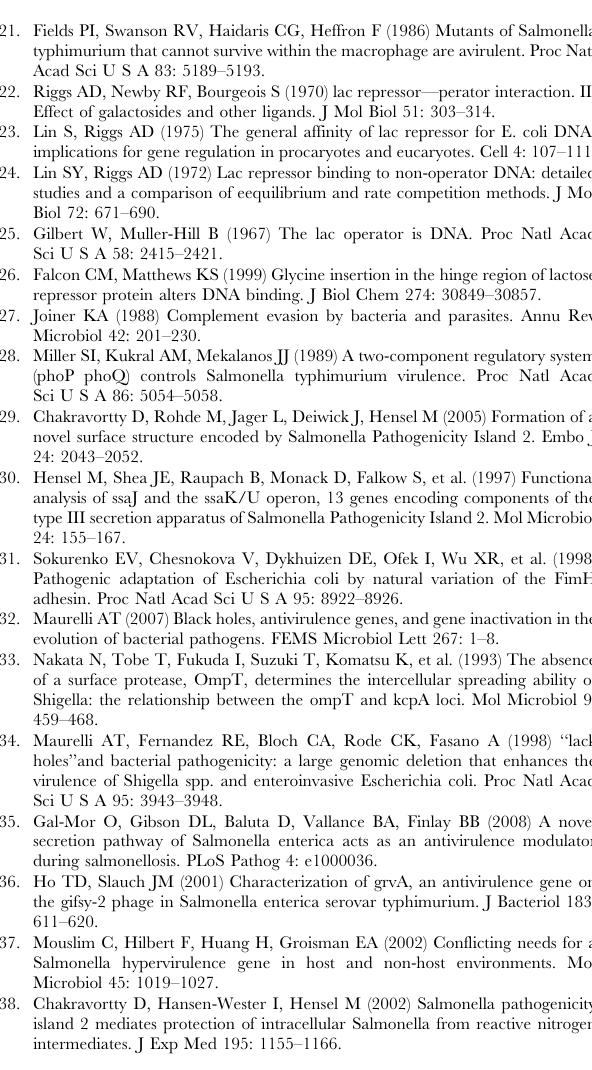
RNA isolated from overnight culture of bacteria was treated with RNase-free DNase and reverse transcribed. cDNA thus generated was used for PCR amplification. (B) PCR amplification of lacI from the genomic DNA of bacteria. In both (A) and (B), PCR was done using lacI-specific primers. rpoD was used as internal control. (C) Western blot analysis of LacI expression in different strains of Salmonella. Equal number of bacteria from overnight culture was lysed and the lysate was used for Western blot analysis. LacI antibody was from Abcam. Figure S2 Effect of LacI on the proliferation of Salmonella in mice infected via intra-gastric route. The graph shows the bacterial load of the spleens of mice infected with Salmonella. Figure S3 Expression of LacI in Salmonella does not affect invasion. HeLa cells were infected as described in Materials and Methods with log-phase bacteria with an MOI of 1. Cells were lysed at 1 h after infection to recover the intracellular bacteria. Percentage of entry was calculated by comparing the number of entered bacteria with the number of bacteria in the pre-inoculum.